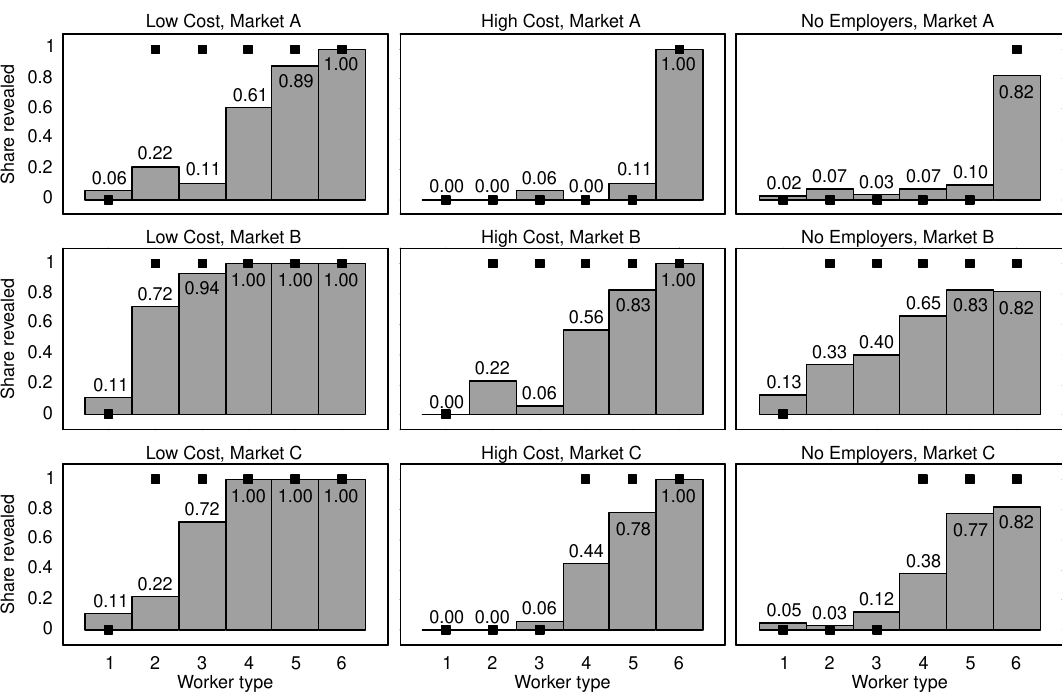
Figure 2. Workers’ decisions dependent on worker types across all markets and treatments. The black markers indicate the corresponding equilibrium